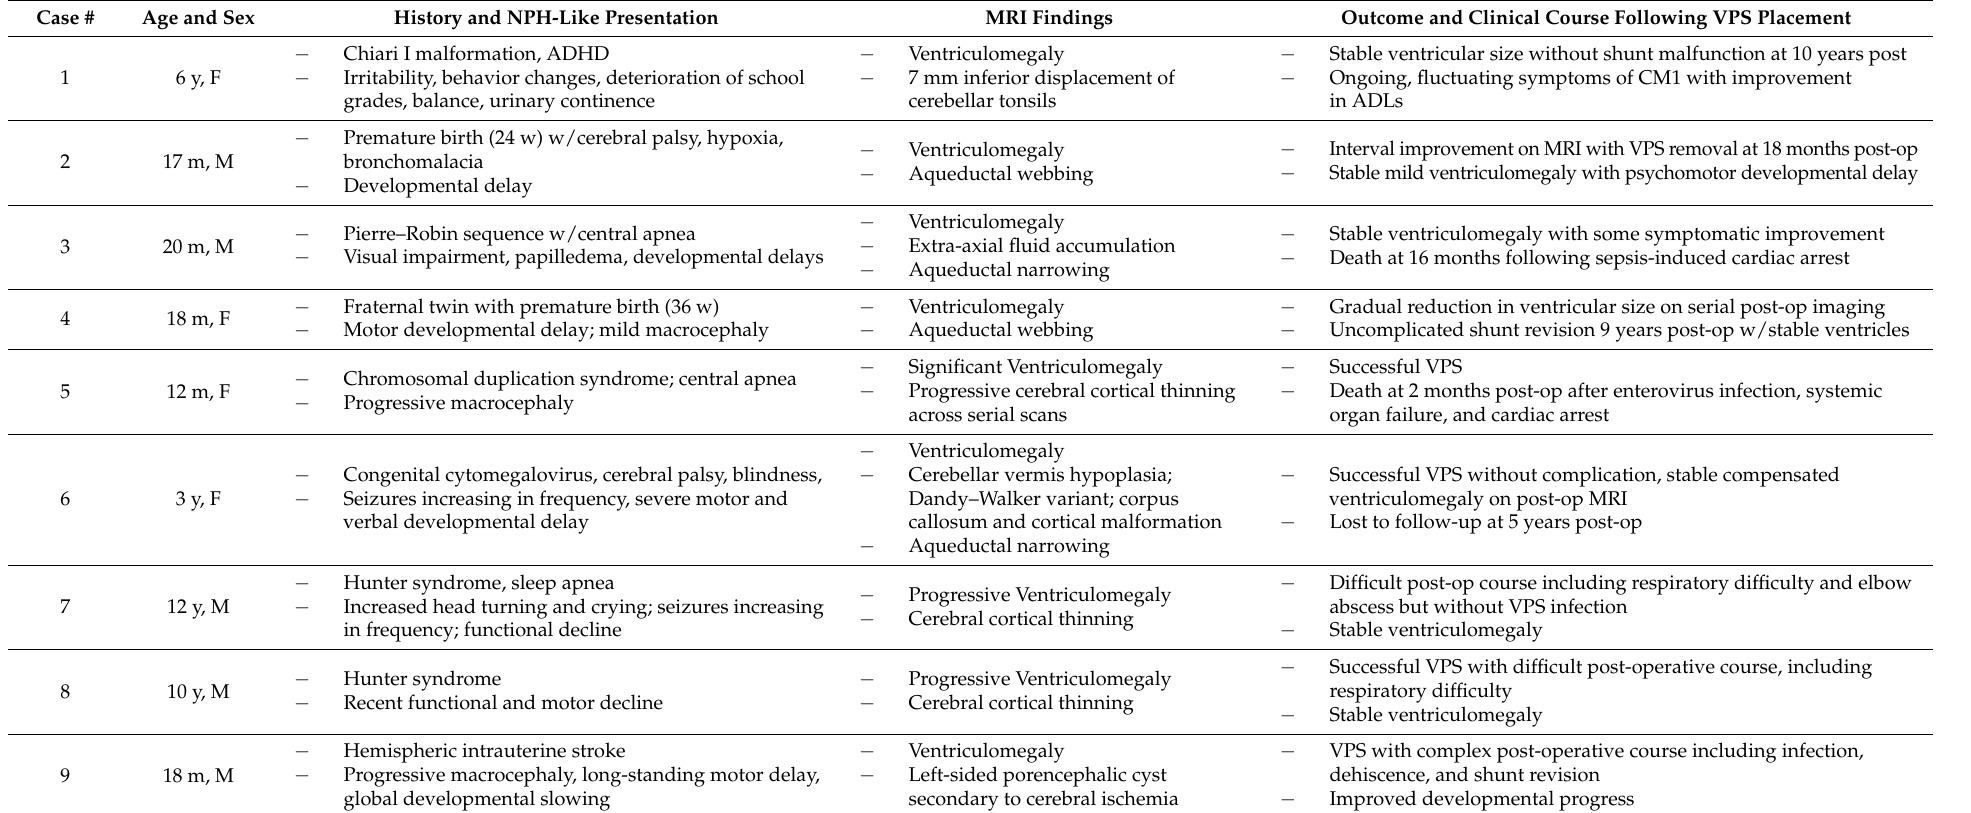
Table 2. Summary of details from nine cases consistent with pediatric NPH from the authors’